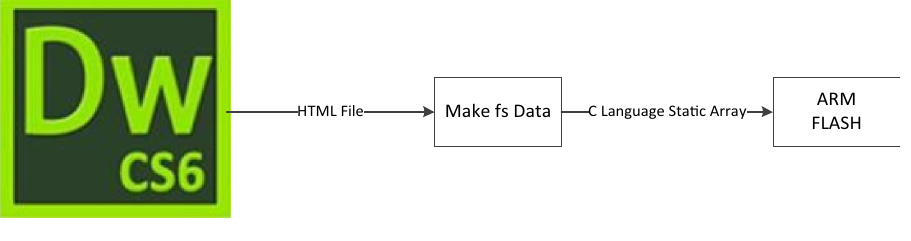
Figure 9. Embedded web page design